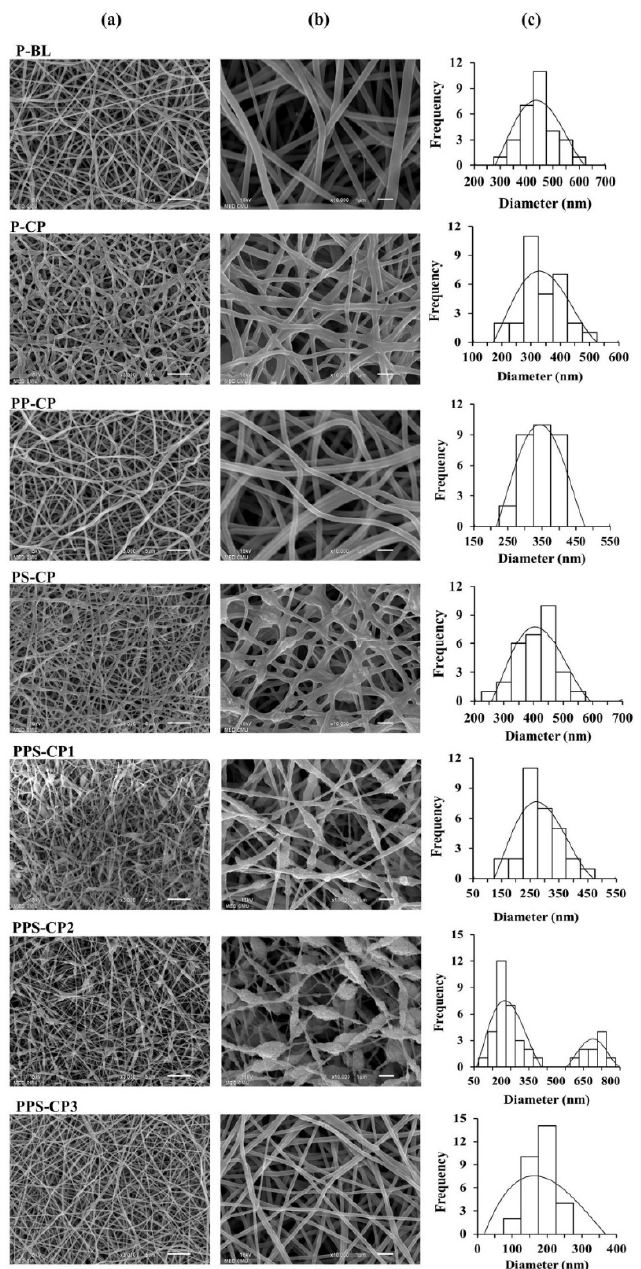
Figure 2. SEM images at magnifications of 3000 × ( a ) and 10,000 × ( b ) and size distribution ( c ) of the electrospun nanofibrous films (ENFs) obtained from various EFASs.